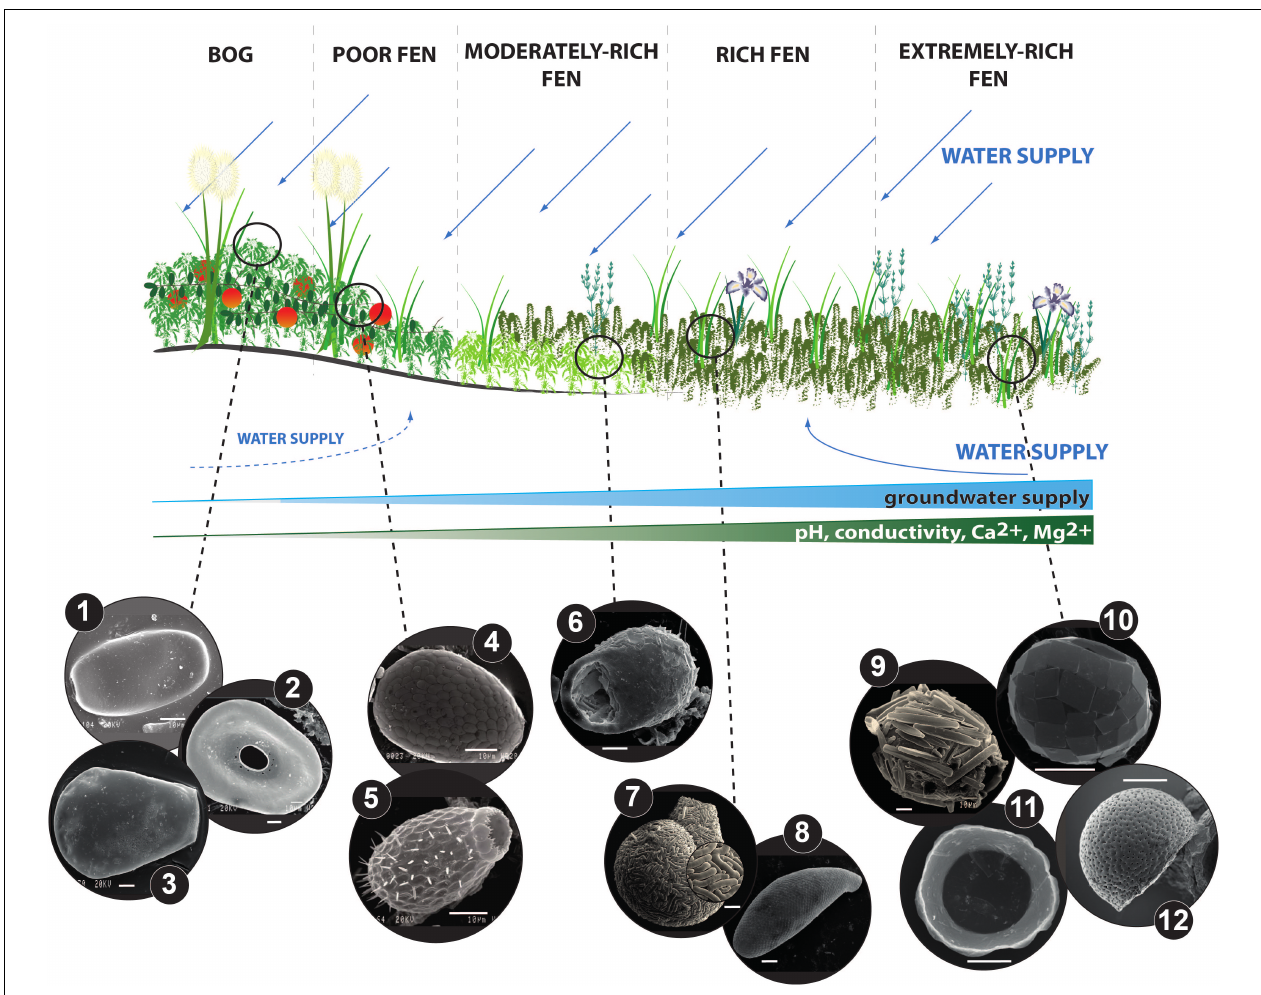
FIGURE 1 | An example of testate amoebae common in various types of peatlands along the bog-rich fen gradient: (1) Archerella flavum (Archer 1877) Loeblich et Tappan 1961, (2) Arcella catinus Penard 1890, (3) Hyalosphenia papilio Leidy 1874, (4) Assulina muscorum Greeff 1888, (5) Euglypha strigosa Ehrenberg 1848, (6) Centropyxis aerophila Deflandre 1929, (7) Lesquereusia spiralis Ehrenberg 1840, (8) Cyphoderia cf. ampulla Ehrenberg 1840, (9) Difflugia bacillariarum Perty 1849, (10) Paraquadrula irregularis Wallich 1863, (11) Microchlamys patella (Claparède et Lachmann 1859) Cockerell 1911, (12) Pyxidicula patens Claparède et Lachman, 1858. The distribution of species along the poor-rich gradient defines the bog-fen habitat that is mainly determined by hydrological dynamics, especially higher supplies of groundwater and nutrient input in the rich end of the gradient. Other variables influencing testate amoebae also vary between the peatland type, e.g., the poor end of the gradient is characterized by a low pH whereas the rich end of the gradient possesses a higher pH and high ground water Ca and Mg concentrations. SEM photos credit: (1–11) : Łukasz Lamentowicz and Mariusz Lamentowicz, (12) : Eckhard Völcker. White scale on each of the photos equals 10 µ